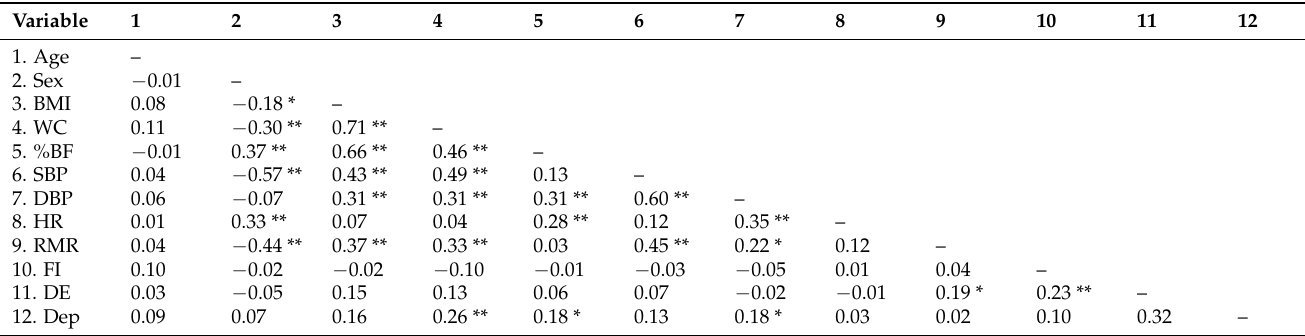
Table 2. Correlations among the variables of interest ( N =